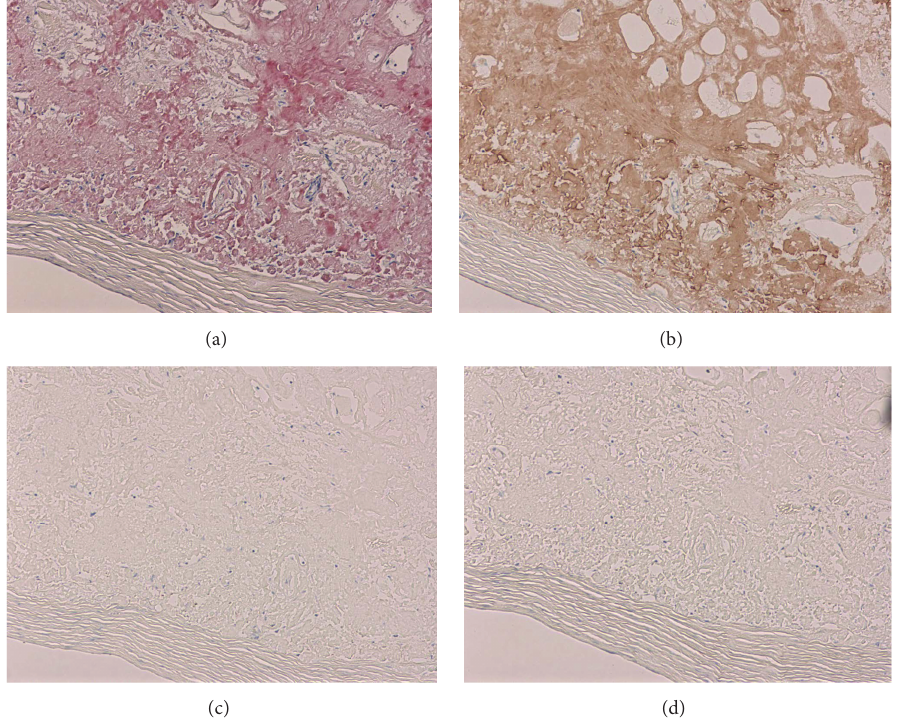
Figure 3: Congo red staining demonstrating amyloid deposition ((a) objective lens, × 10). Immunohistological staining revealing positivity for lambda light chain ((b) objective lens, × 10) and negativity for kappa or transthyretin ((c), (d) objective lens, ×